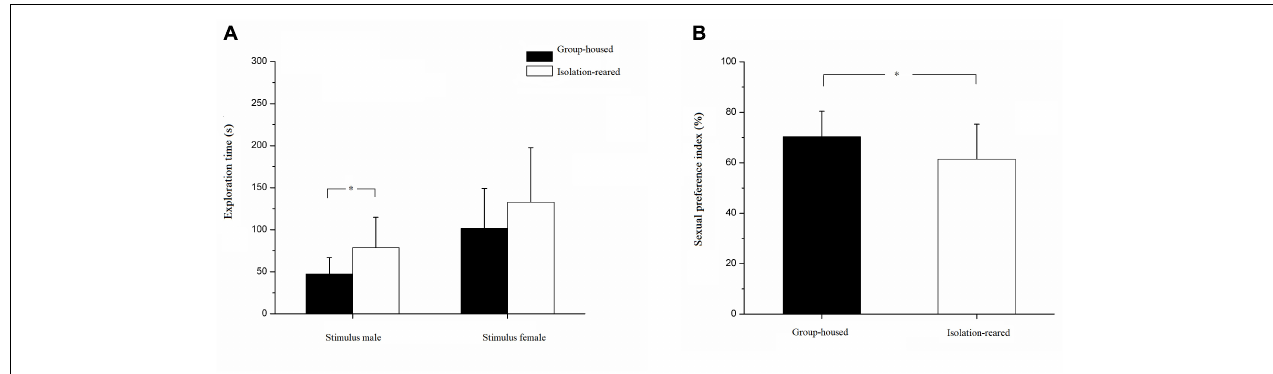
FIGURE 5 | Results of sexual preference test. (A) The exploration time of isolation-reared and group-housed mice toward stimulus male and female. (B) The sexual preference indexes of isolation-reared and group-housed mice. ∗ Indicate p < 0.05. Bar represent mean. Error bar represent SD.